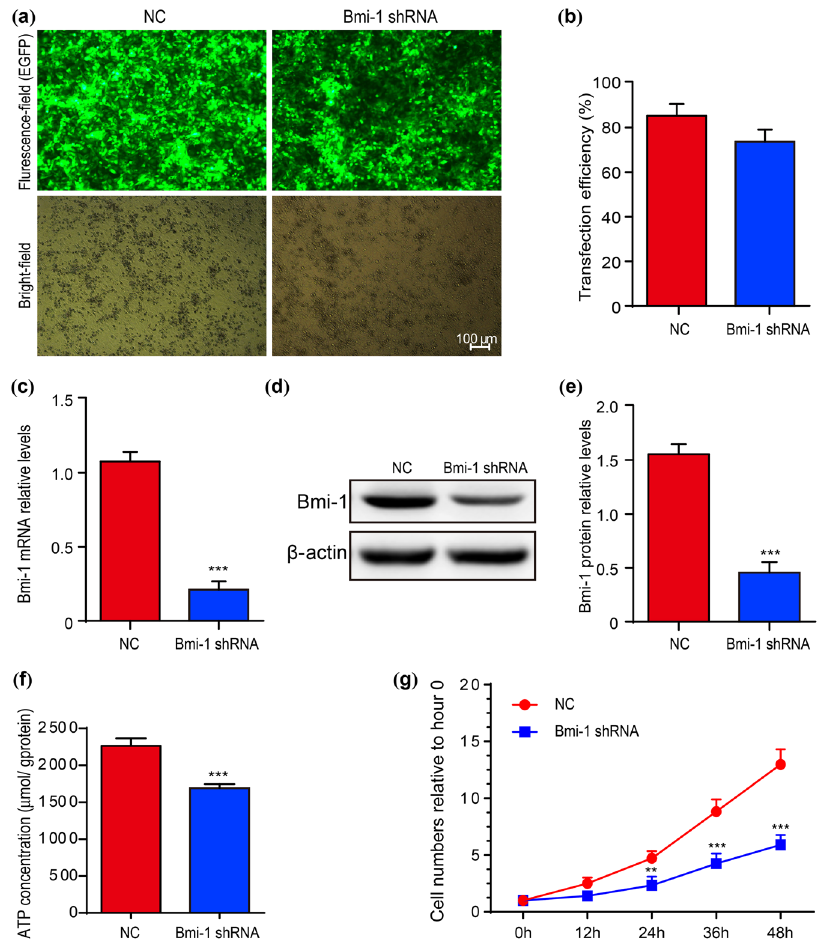
Figure 5. Human Bmi - 1 shRNA knocked down Bmi-1 in HK2 cells in vitro . ( a ) Representative micrographs of HK2 cells from human Bmi - 1 -specific shRNA (Bmi-1 shRNA) and negative control-shRNA (NC) groups by fluorescence microscopy in fluorescence-field for EGFP positive or bright field. ( b ) Transfection efficiency was measured as percentage EGFP-positive cells relative to total cells, 4 days after transfection. ( c ) Human Bmi - 1 mRNA in HK2 cells from NC and Bmi - 1 shRNA-transfected cells determined by real time RT-PCR as a ratio to GAPDH mRNA, relative to NC. ( d ) Western blots of HK2 extracts showing Bmi-1. β -actin was the loading control. ( e ) Bmi-1 protein relative to β -actin assessed by densitometric analysis. ( f ) ATP concentration of HK2 determined by spectrophotometry. ( g ) Transfected HK2 cells proliferation determined by CCK-8 assays and spectrophotometry at 450 nm. Cell number determined on indicated hours is presented relative to cell number at hour 0. Six biological replicates were used for these studies per experiment. Values are means ± SEM of six determinations. ** P < 0.01, *** P < 0.001 compared with NC